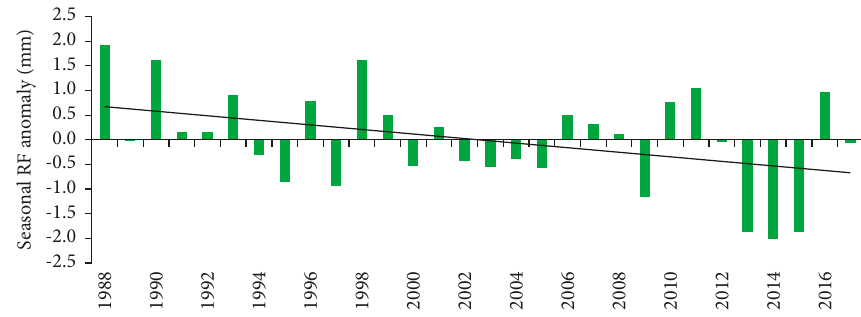
Figure 4: Kiremt rainfall anomaly (JJAS) at Welmera district in the period of 1988–2017.